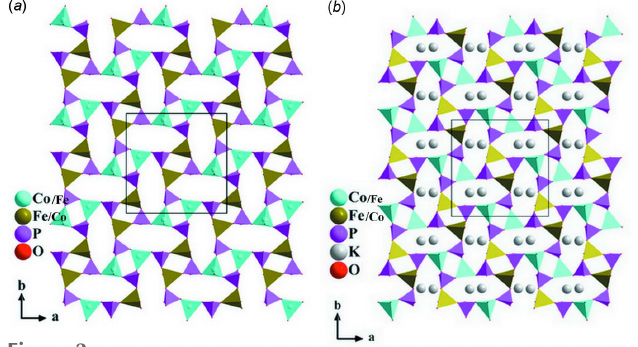
Figure 2 ( a ) A (001) layer at z ’ 0 and ( b ) at z ’ 0.5, resulting from vertex-sharing between TM O 4 and PO 4 tetrahedra. Rings formed by eight corner- sharing tetrahedra according to the sequence DDDDUUUU are shown on the left.